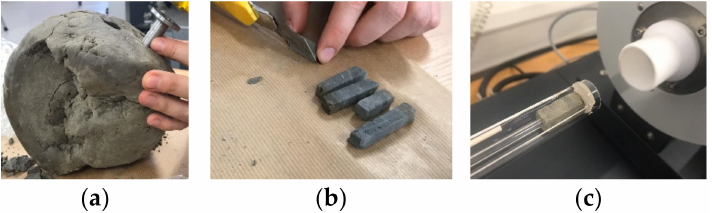
Figure 8. ( a ) Drill core sample preparation; ( b ) cuboid dilatometry sample preparation; ( c ) drill core sample inside the sample holder of the